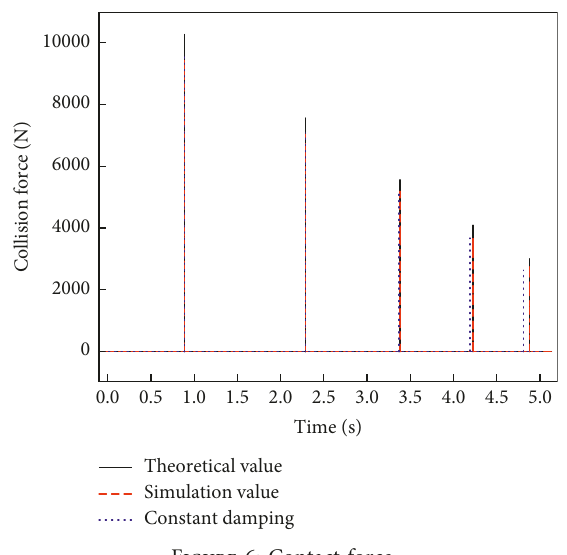
138 . 93525 6 . 00288 v (cid:30) + −